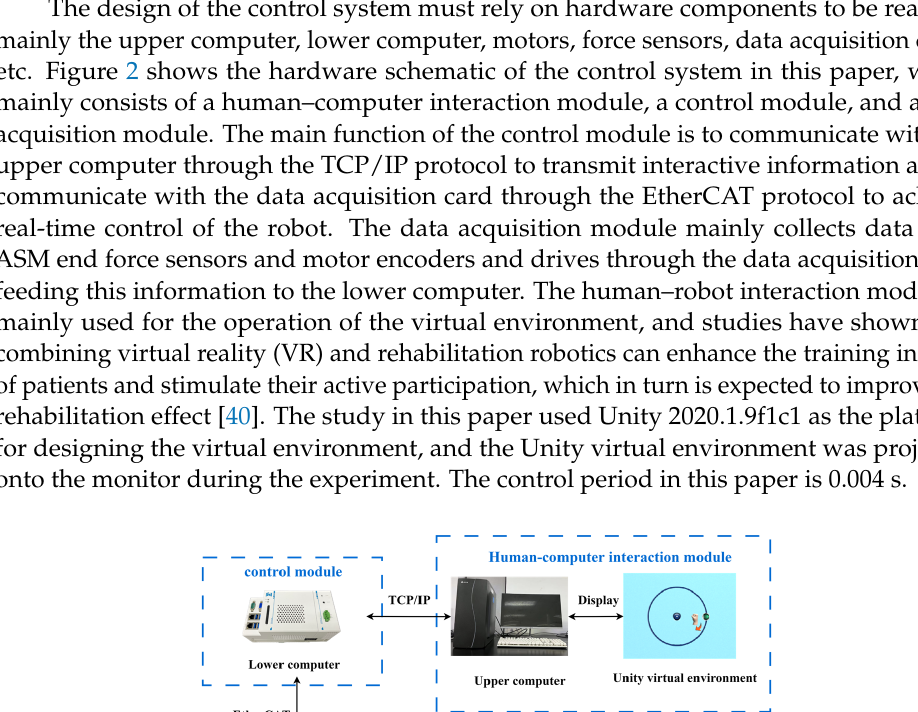
Figure 1. The design of the EBULRR platform.